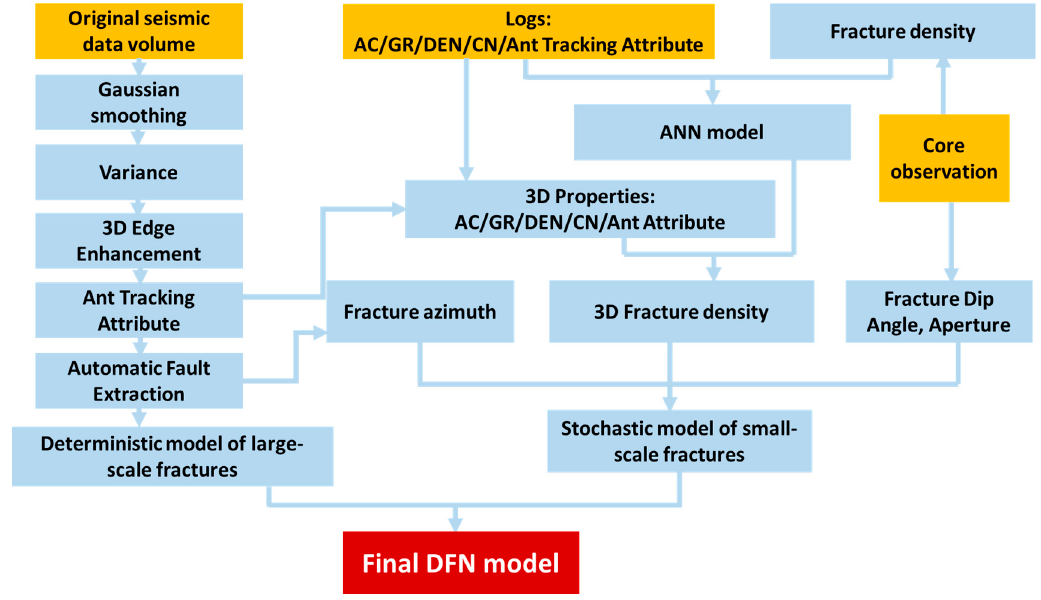
Figure 1. The workflow for DFN modelling used in this study. Orange areas represent original data; light blue areas represent processed data or methods; the red area represents results.